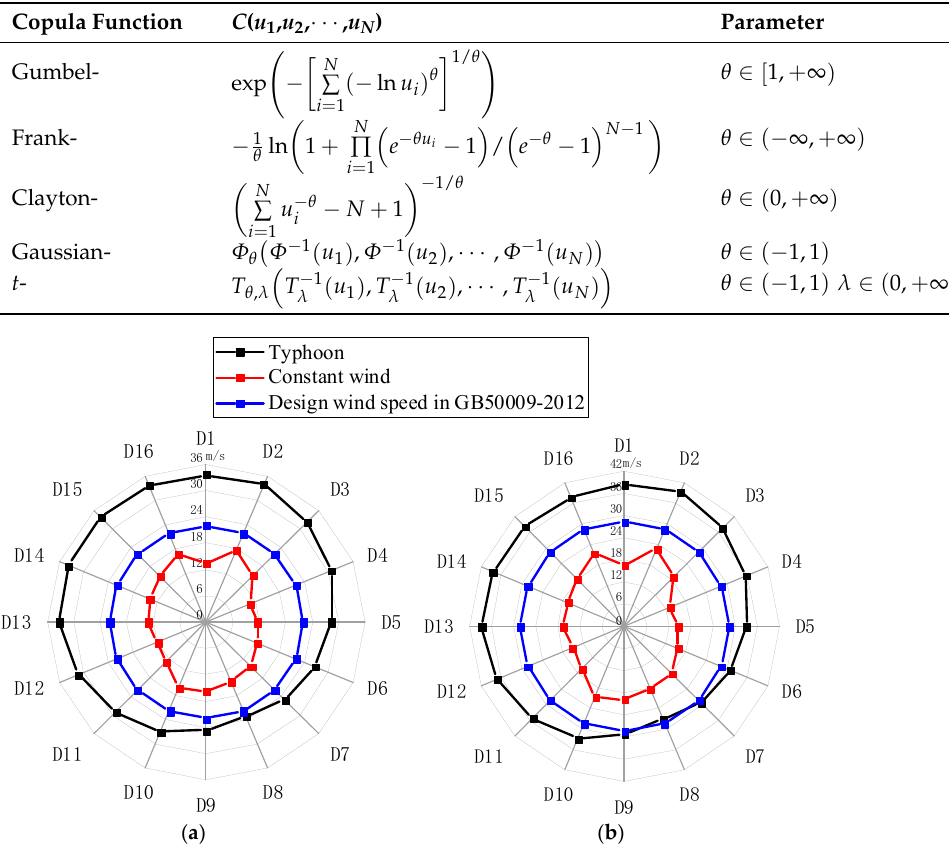
Figure 15. Comparison of the extreme wind speed with the design wind speed given by the code in Ningbo. ( a ) Ten-year return period; ( b ) fifty-year return period. Table 2. Extreme wind speed of each wind direction angle under different return periods (unit m/s) (considering wind direction